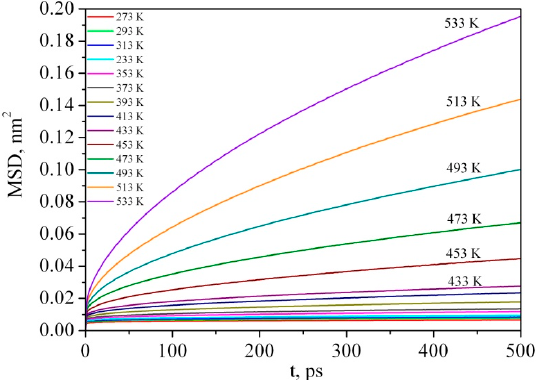
Figure 3. Temperature dependence of mean squared displacement (MSD) curves of PMMA at 0.1 MPa.